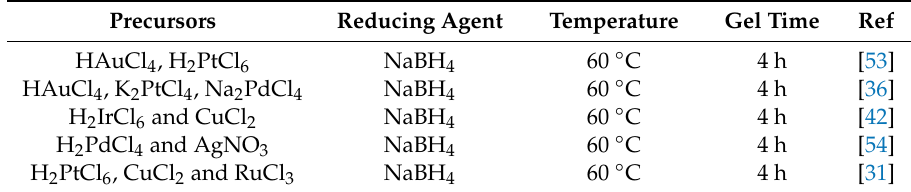
Figure 3. ( a ) The mass and specific activities of the PdxM-Pt core–shell aerogels (M=Au, Ni, Co, Cu) as a function of the lattice parameter and Pd-Pd interatomic distance of the PdxM core aerogels [37]. Copyright (2017) John Wiley and Sons. ( b ) Nyquist plots of the Ag rod (blue) and carbon paper (black). The inset shows the Nyquist plots of the Ag Wire@CP and Ag Wire-gel. ( c ) Power density and ( d ) polarization curves of H 2 O 2 -fed fuel cells with Ag Wire-gel, Ag Wire@CP, and Ag rod cathodes at different current densities [55]. Copyright (2019) Royal Society of Chemistry. XPS spectra of ( e ) Cu 2p and ( f ) Pd 3d levels of PdCu aerogels [56]. Copyright (2018) John Wiley and Sons. Table 2. Gel preparation environment commonly used in